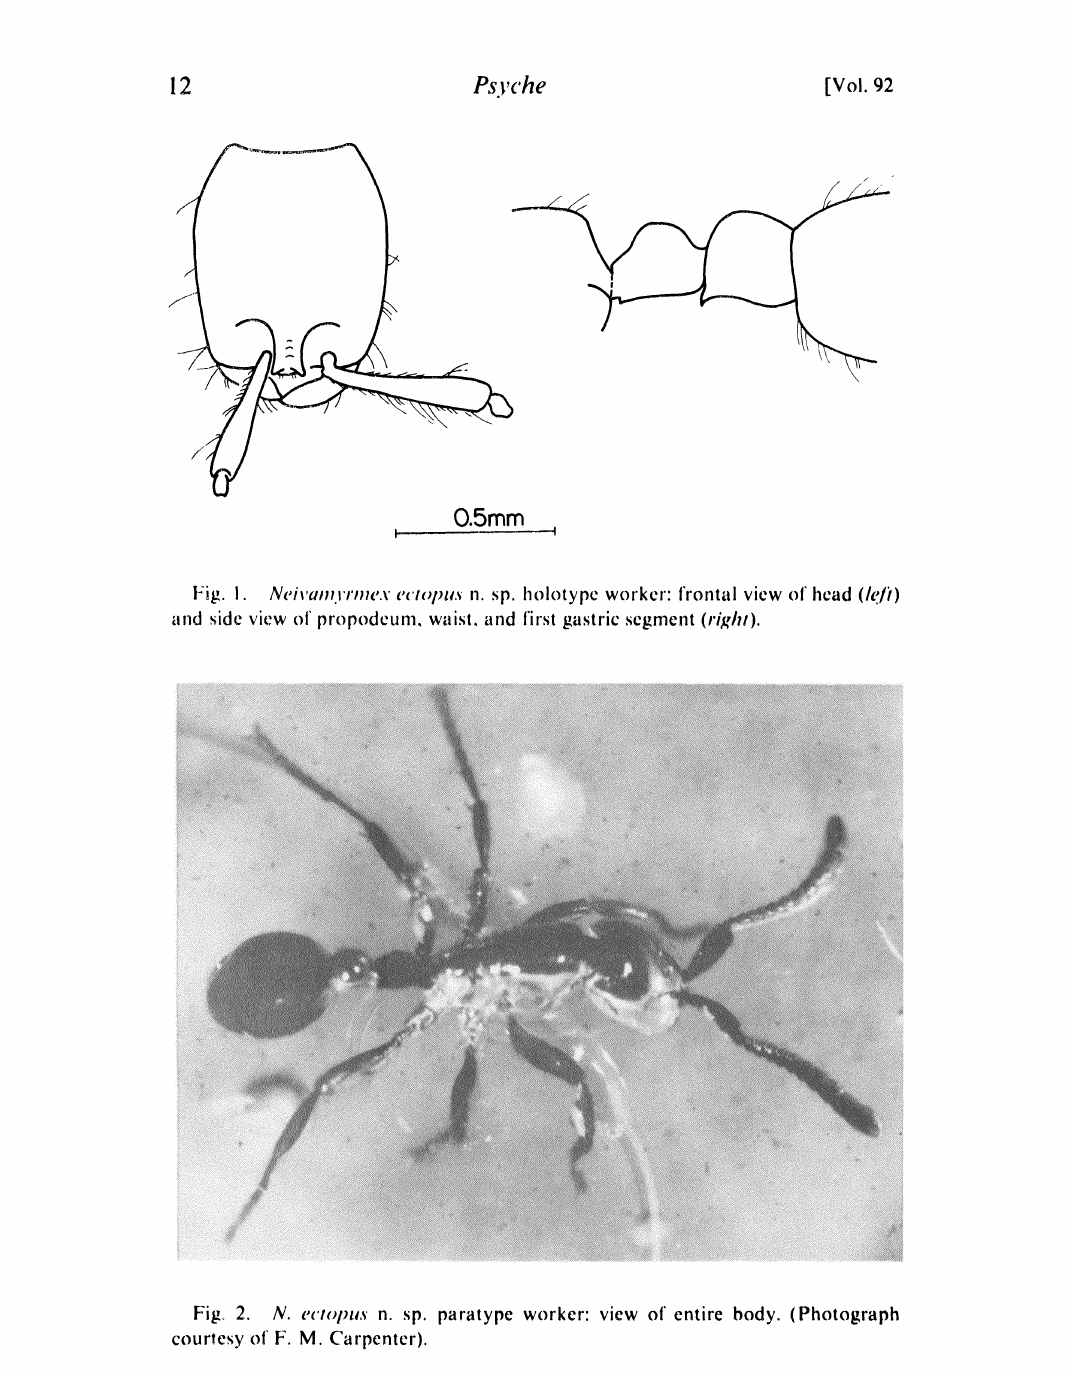
Fig, 2. N. ectopus n. sp. paratype worker: view of entire body. (Photograph courtesy of F. M.